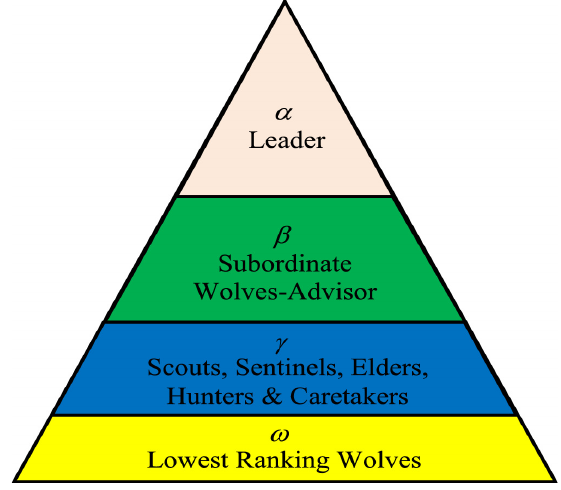
Figure 1. GWO social hierarchy.